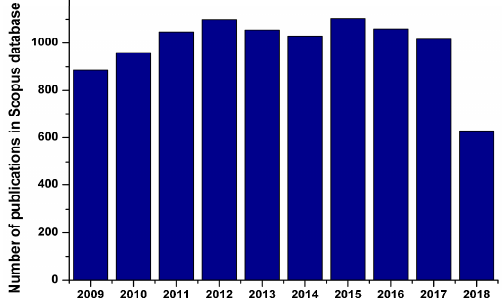
Figure 1. The number of publications in Scopus database (keywords “alcohol oxidation”, as of September 2018).